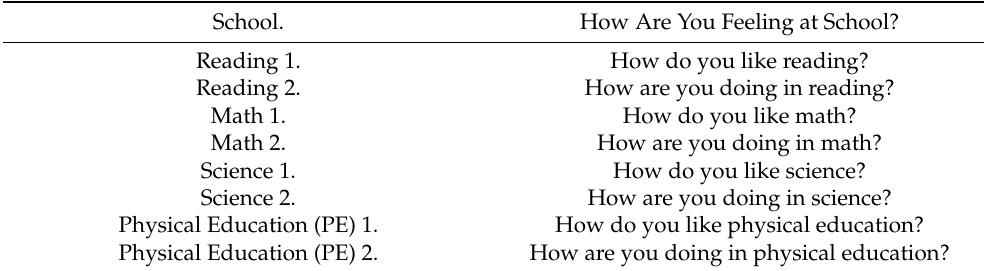
Table 1. Nine questions used in